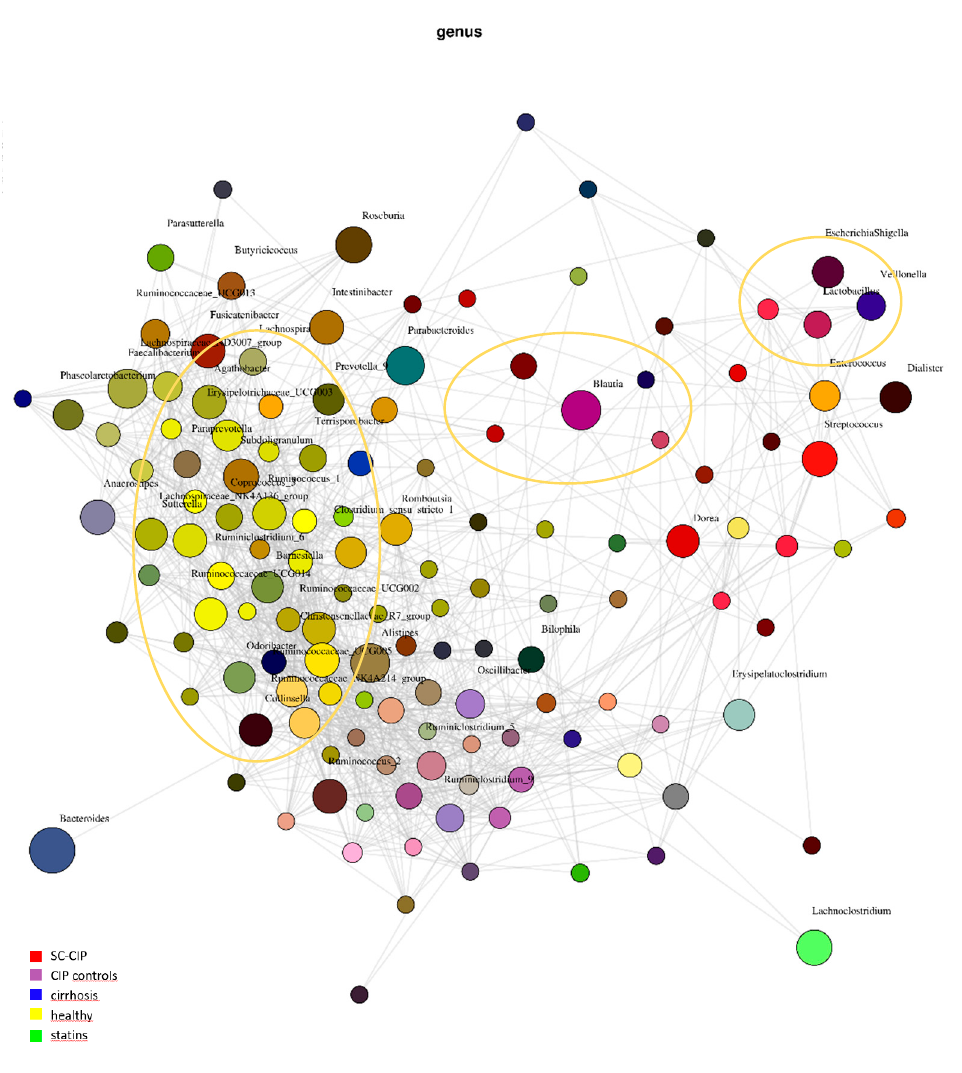
Figure 4. Principal coordinates analysis (PCoA) Plot for Network Analysis for beta diversity using Spearman’s rho correlation. Taxa are drawn as dots, taxa abundance as dot size and edges show positive and negative associations. Green: statin intake, red: SC-CIP, purple: CIP controls, blue: cirrhosis, yellow: healthy. With overlap of colors, between groups similarities of microbiome composition are indicated. The described overlaps of the genera Blautia and Lactobacillus are marked with purple circles, the close relation of the group with statin intake and healthy is marked with a yellow circle.